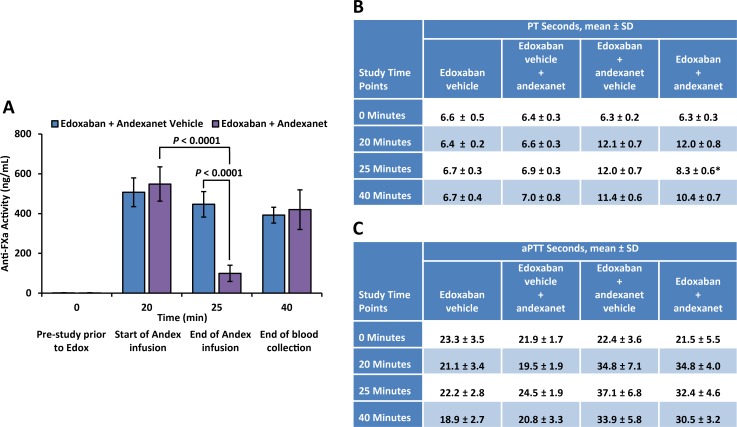
Change in pharmacodynamic parameters following administration of andexanet in edoxaban-anticoagulated rabbits.(A) Edoxaban anti-FXa activity was measured by a modified anti-FXa activity assay. The anti-FXa activity in unknown samples was quantified using the known concentrations of edoxaban in rabbit plasma as standards and expressed as ng/mL. Data are plotted as mean ± standard deviation. (B) PT measurements in seconds. (C) aPTT measurements in seconds. Determination of PT and aPTT was performed on an Instrumentation Laboratory ACL Elite. HemosIL PT-Fibrinogen kit was used for PT measurements, and HemosIL SynthASil kit was used for aPTT measurements.